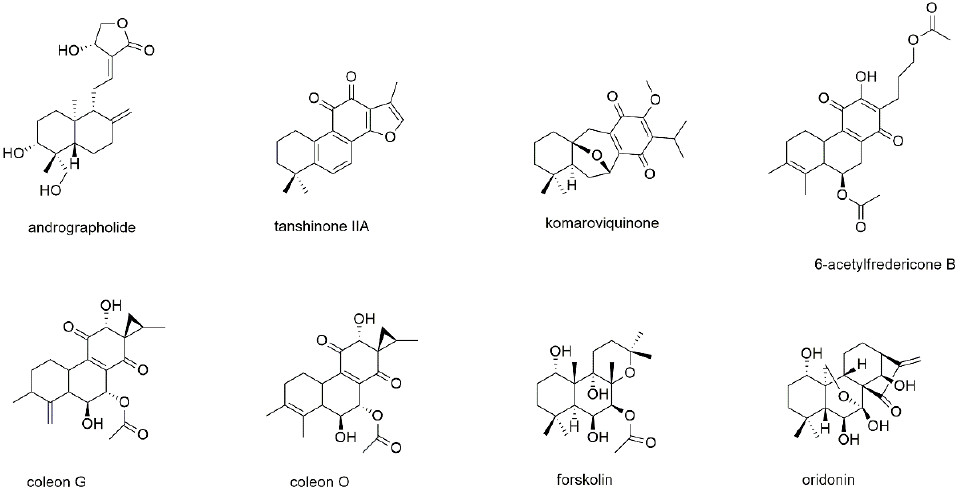
Figure 12. Diterpenes with reported activity against myeloma cell lines.